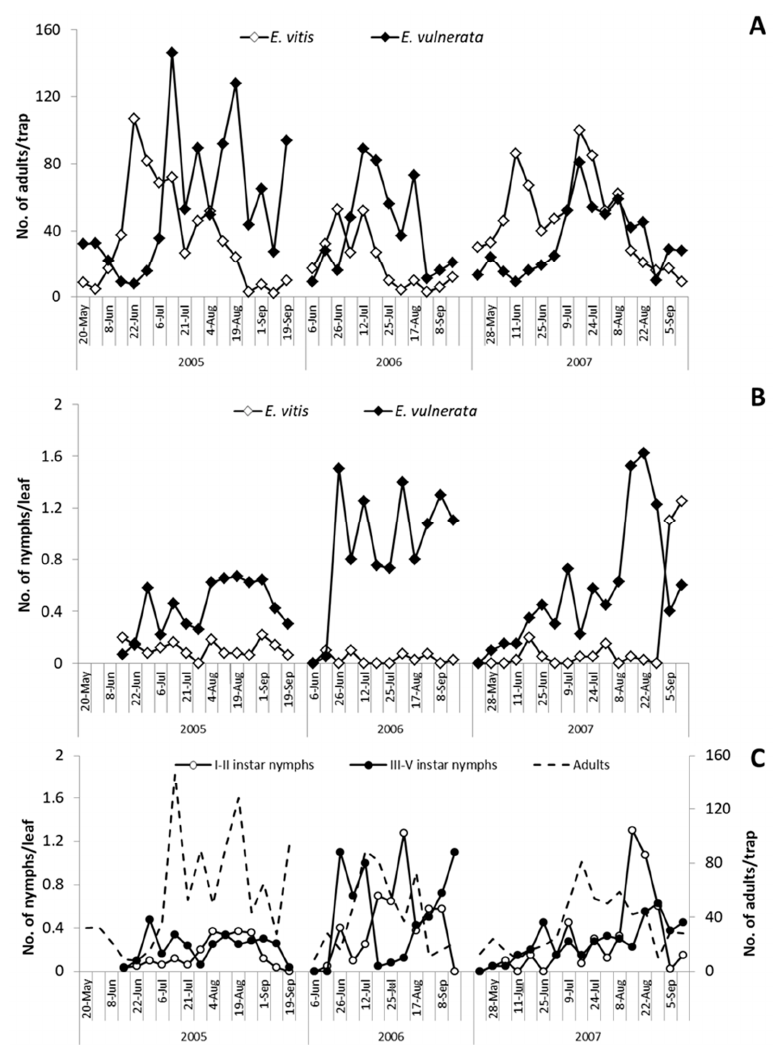
Figure 1. Adult catches ( A ) and nymphs seasonal abundance ( B ) of Empoasca vitis and Erasmoneura vulnerata on Vitis labrusca (cv. Isabella). The phenology of Erasmoneura vulnerata on Vitis labrusca (cv. Isabella) is reported below ( C ). Adults were counted on yellow sticky traps, while nymphs were counted on leaves during three subsequent seasons.